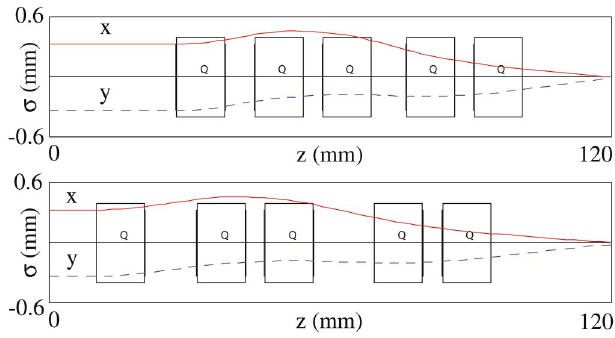
FIG. 8. (Color) Beam energy: 72 MeV (top) and 92 MeV